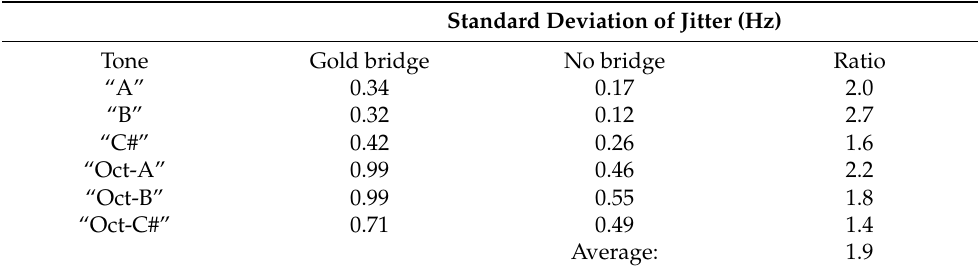
Table 1. Standard deviation of the frequency jitter of tones played on the saxophone with or without a mounted gold-plated